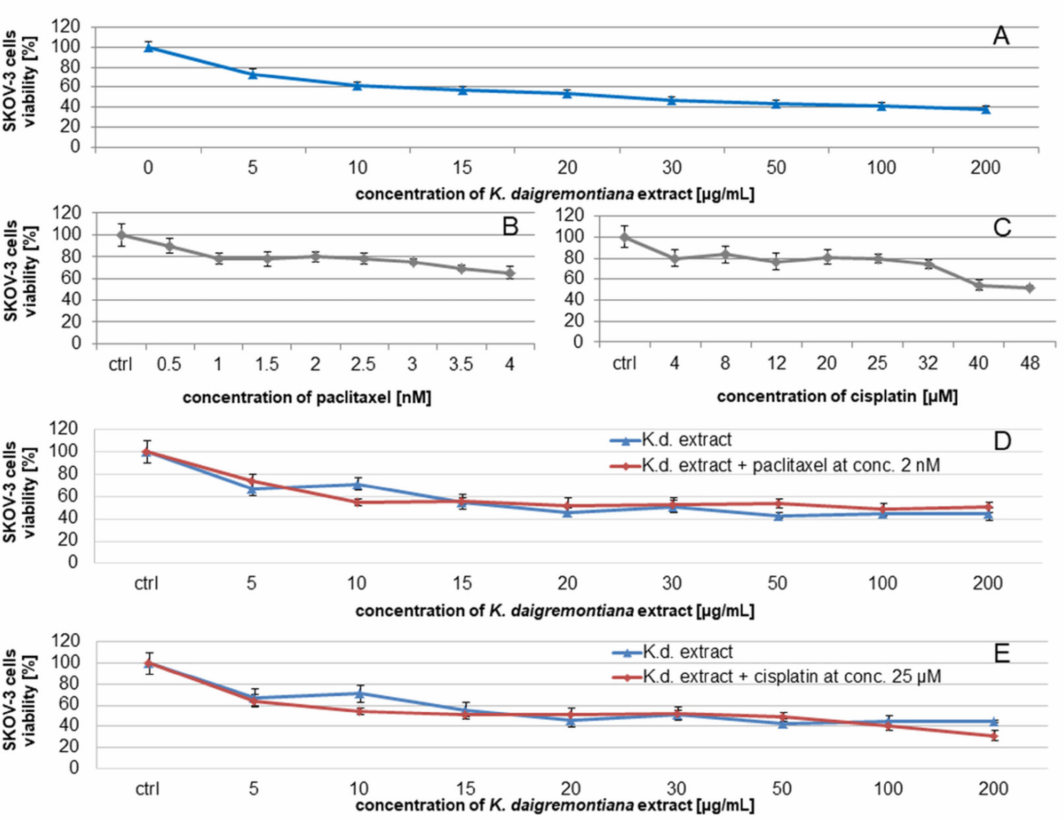
Figure 1. The viability of SKOV-3 cells treated with the water extract of K. daigremontiana ( A ) or cytostatics (paclitaxel ( B ) or cisplatin ( C )) or the extract with the cytostatics (paclitaxel ( D ) or cisplatin ( E )). The results were obtained via MTT assay (two independent experiments, four repetitions, n = 8) after 24 h of incubation of the cells with the extract or cytostatics. Error bars represent standard deviations. ANOVA was performed with post hoc Tukey’s test ( p <